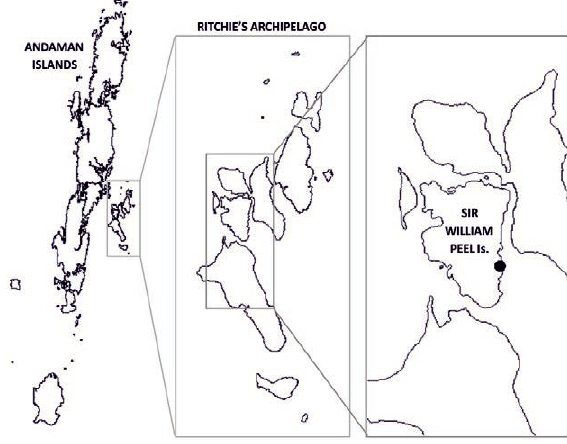
Figure 2. Map showing study area. indicates the locality of Pemphis acidula